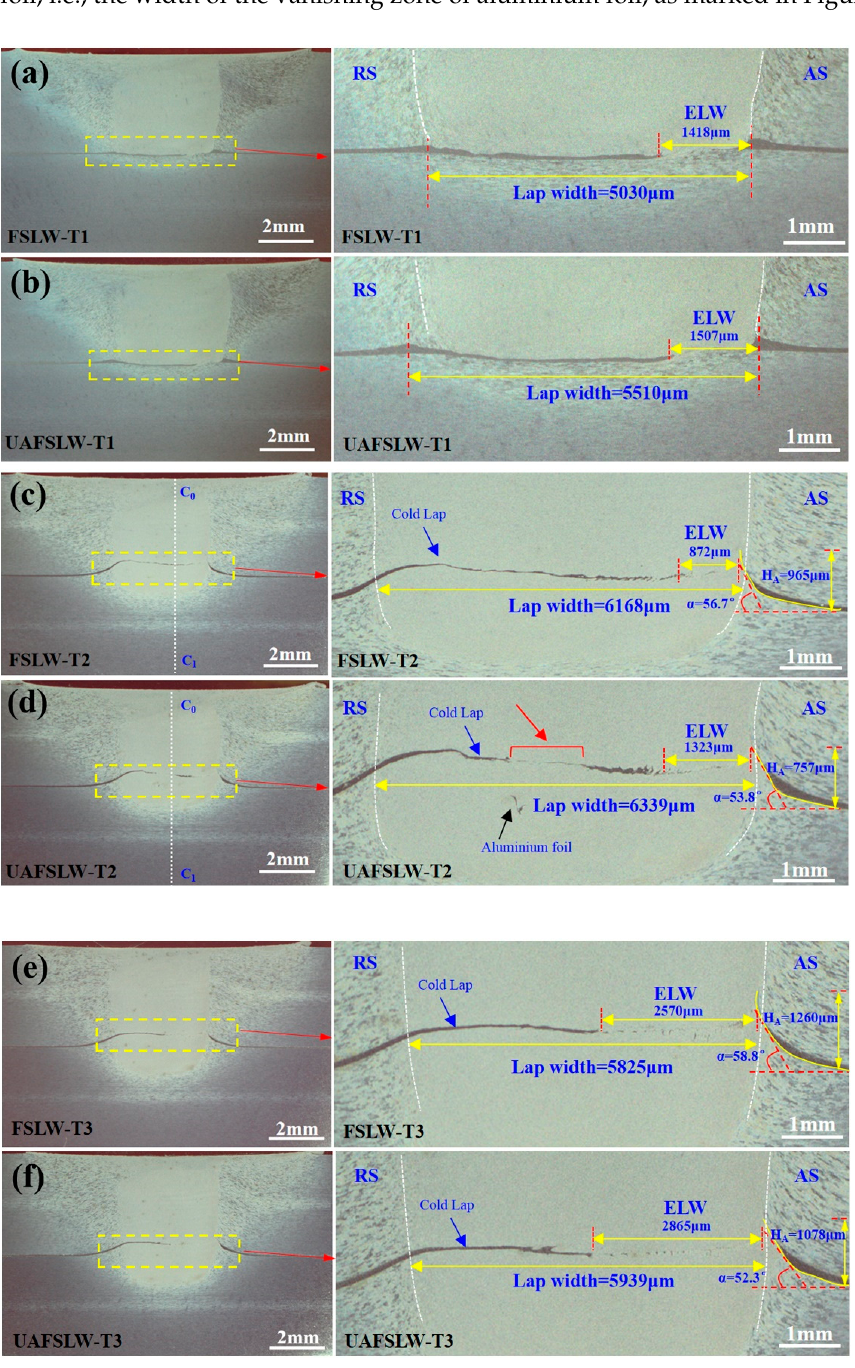
Figure 5. Transverse cross section of lap joints obtained by the different tools ( a , b ) friction stir lap welding (FSLW) and ultrasonic-assisted friction stir lap welding (UAFSLW) welded by tool T1, ( c , d ) FSLW and UAFSLW welded by tool T2, and ( e , f ) FSLW and UAFSLW welded by tool T3.